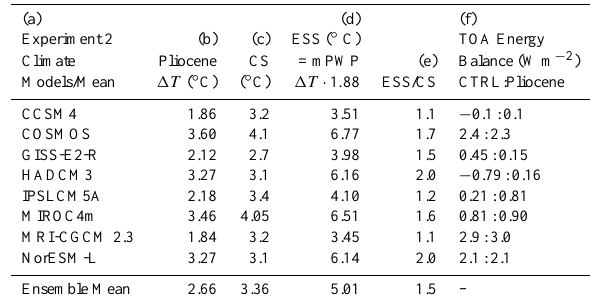
Table 2. (a) Experiment 2 models included in the assessment of Cli- mate Sensitivity (CS) versus Earth System Sensitivity (ESS) plus the ensemble means; (b) calculated anomaly in global annual mean surface air temperatures ( ◦ C); (c) published estimates of CS ( ◦ C); (d) calculated estimates of ESS ( ◦ C); (e) ratio of ESS to CS; (f) en- ergy balance at the Top of the Atmosphere in Wm − 2 for the control and Pliocene